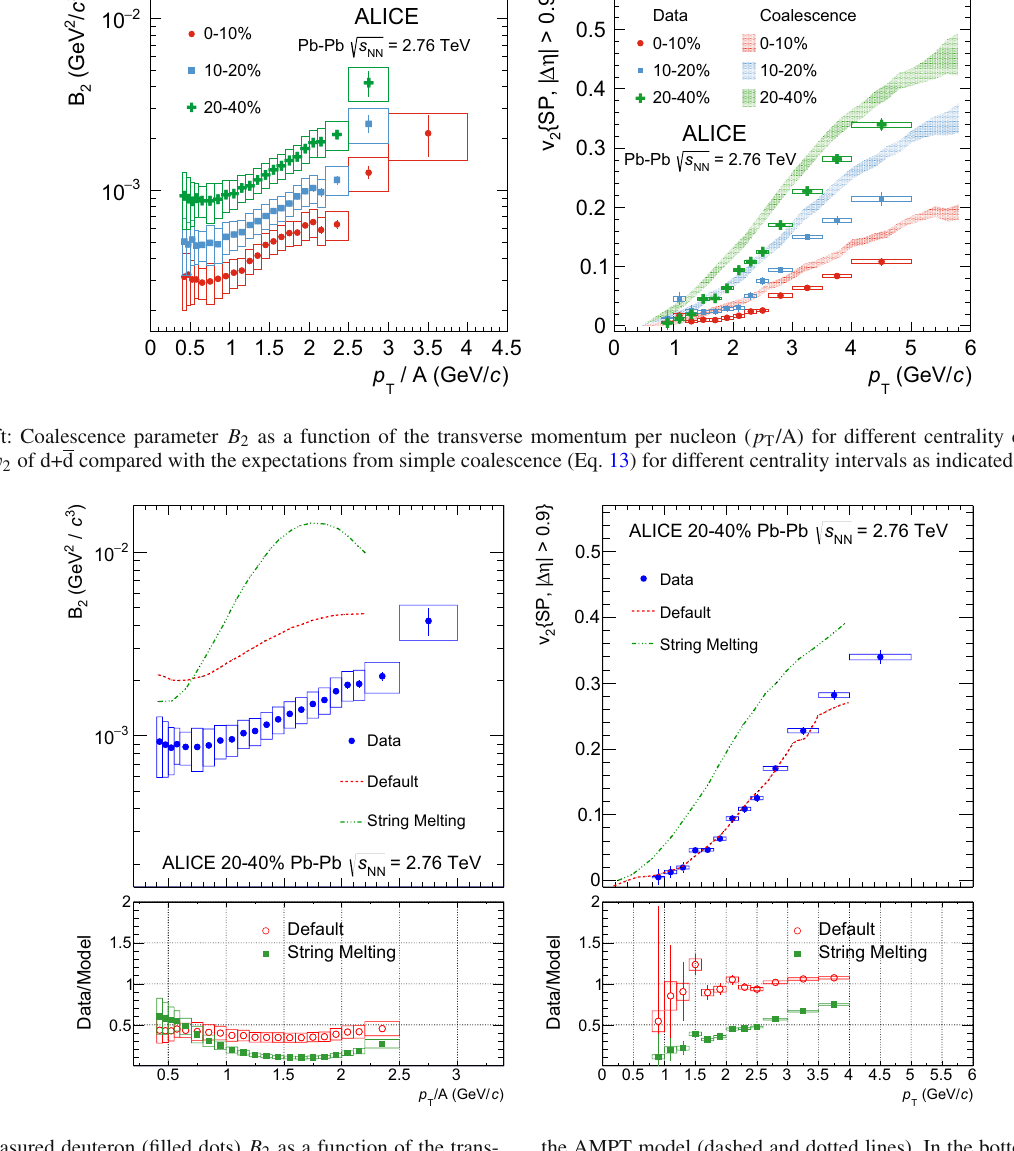
(filled markers) together with the published AMPT expec- tations (lines), while in the bottom panel the ratios